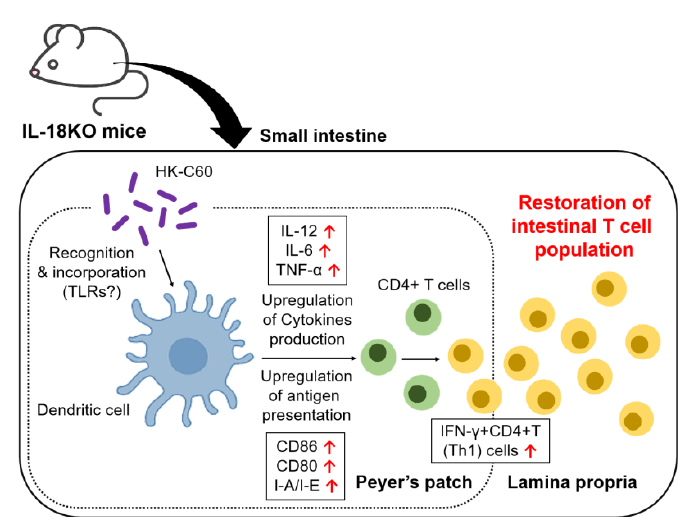
Figure 5. The hypothetical model of immunomodulatory effect of HK-C60 in DCs based effector CD4+ T cells generation in small intestine of IL-18KO mice. HK-C60 stimulation induces over activation of IL-18-deficinet DCs. The DCs activity directory correlated with antigen specific effector CD4+ T cells generation, such as cytokine production and expression of antigen presenting molecules as well as antigen uptake, are all upregulated in the HK-C60 stimulated IL-18-deficient DCs. As a result, effector CD4+ T cells, such as Th1 cells, generation is promoted by the over activated IL-18-deficient DCs. Supplementary Materials: The following are available online at www.mdpi.com/xxx/s1, Table S1. The Ab staining combination in flow cytometry analysis; Figure S1: The decreasing of specific population in CD45+ cells in SI-LP of IL-18KO mice, Figure S2: Age-associate decreasing of CD3+ T cells in SI-LP, Figure S3: HK-C60 induces cytokine production and cellular activation in BMDCs, Figure S4: The characterization of T cells in non-intestinal environment and PP, Figure S5: The thymic development of T cells, Figure S6: The number of PP isolated cells, Figure S7: The basal status of primary PP DCs.